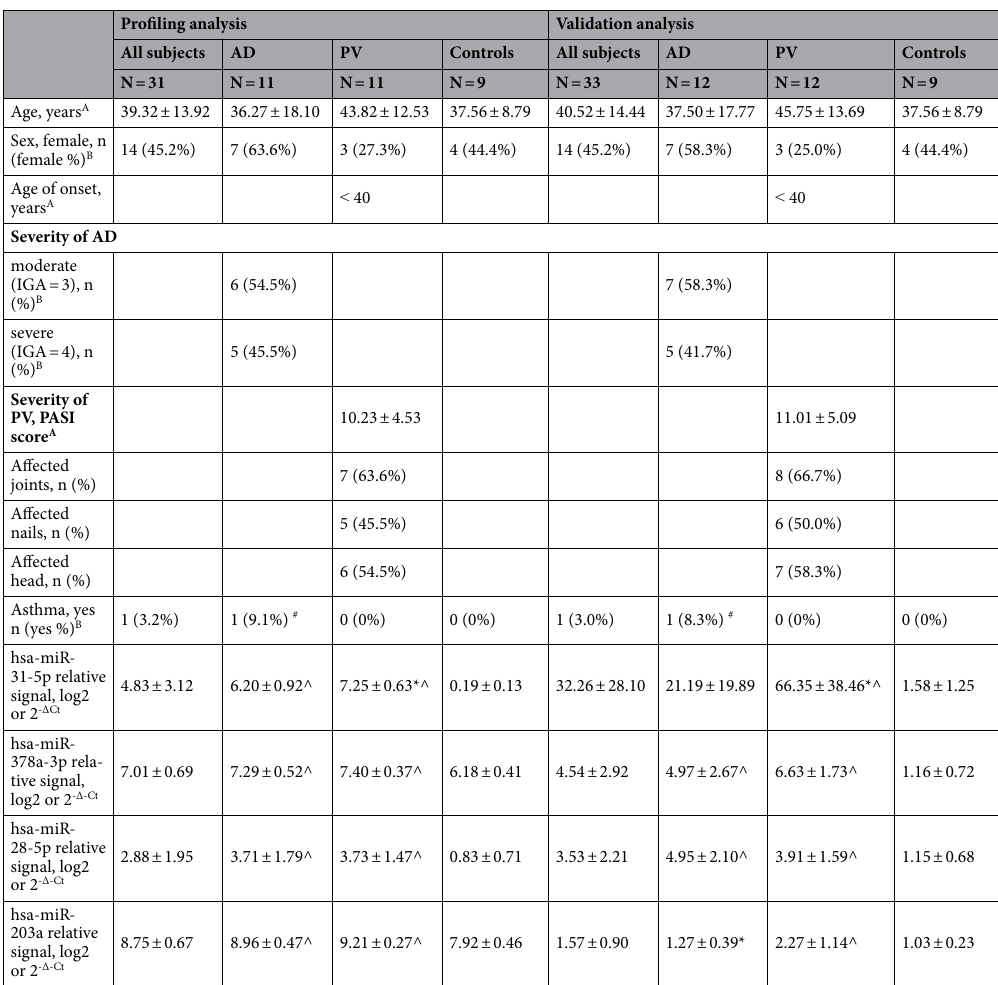
Table 1. Characteristics of recruited AD and PV patients and age matched controls for the study of skin tissue samples. AD atopic dermatitis, PV psoriasis vulgaris, IGA investigator’s global assessment score for overall severity of AD signs, PASI psoriasis area severity index for overall severity of psoriasis signs. A Data are shown as mean ± standard deviation (SD). ANOVA (post hoc test) *p ˂ 0.05 comparing AD vs PV, ^ p ˂ 0.05 compared to controls. B Data are shown as absolute numbers and percentages in brackets. Chi Square test, # p ˂